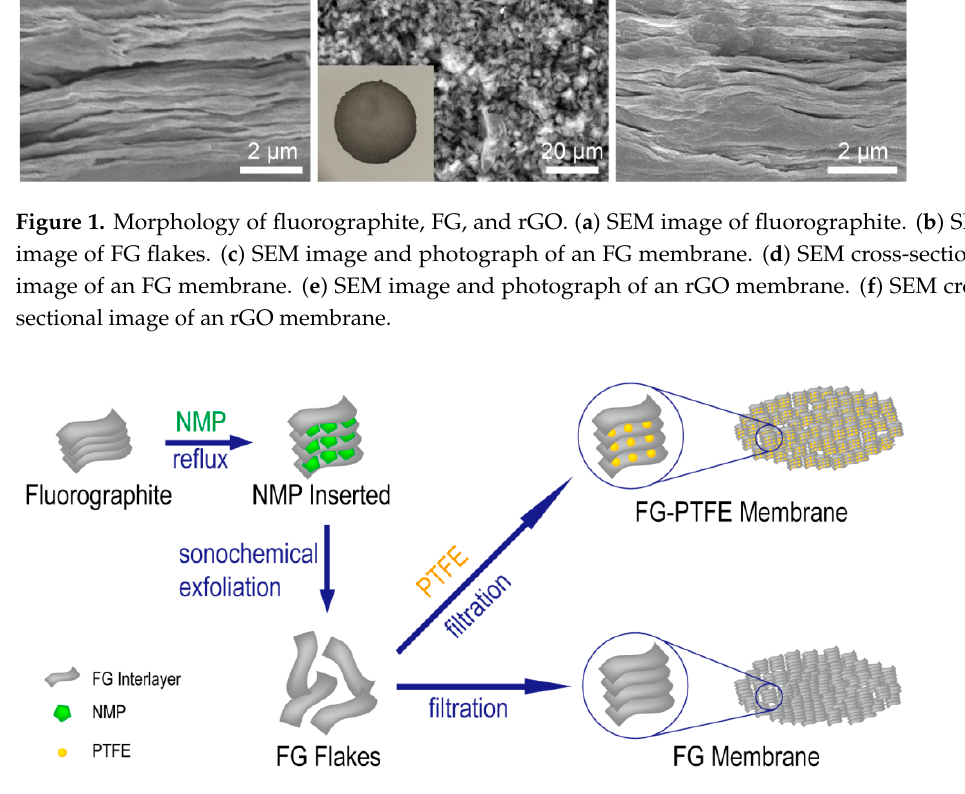
Scheme 1. Preparation of FG membranes and FG-PTFE membranes.